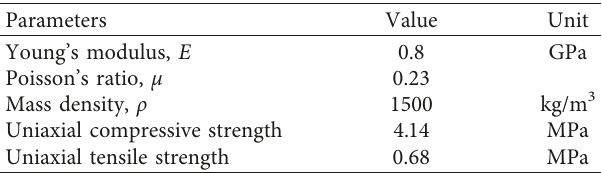
Figure 1: High-pressure nitrogen blasting and cracking experimental system of coal and rock mass.1: nitrogen cylinders; 2: air compressor; 3: gas booster pump; 4, 6, 7, 8, 18, 19, and 20: control valve; 5: electrical contact pressure gauge; 9: 1L high-pressure vessel; 10 and 11: 2L high-pressure vessel; 12–14: the vent valve; 15–17: mechanical pressure gauge; 21: the pneumatic high-pressure shut-off ball valve (pneumatic valve); 22: release tube; 23: releasing hole; 24: pressure chamber; 25: gaskets; 26: specimen; 27: millisecond pressure transmitter; 28: dynamic and static strain gauge; 29: computer acquisition system. Table 1: The physicomechanical parameters of the concrete specimen.